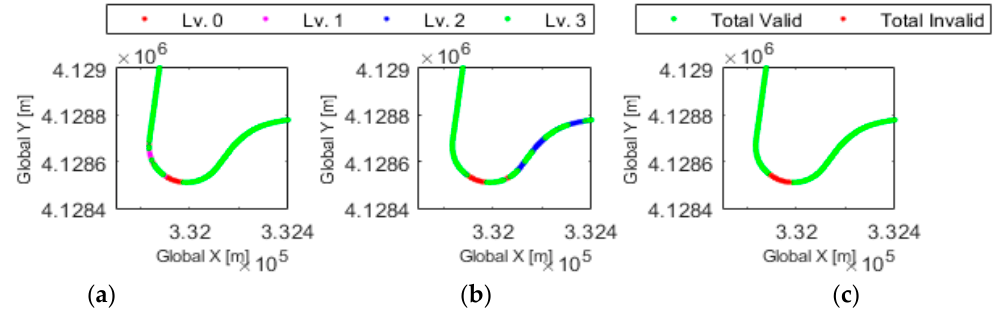
Figure 5. Lane quality analysis of front vision at the highway junction (a junction on the Korean Expressway). ( a ) right lane quality; ( b ) left lane quality; ( c ) total lane valid section.